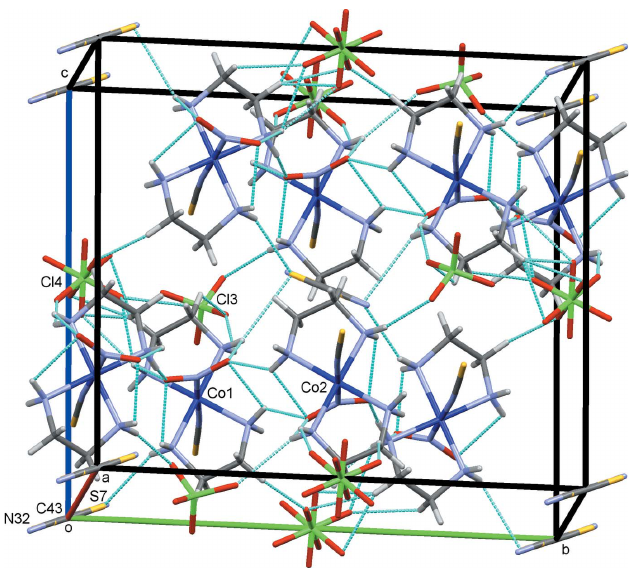
Figure 6 The crystal structure of (III), projected along a . N—H (cid:2)(cid:2)(cid:2) O/N and C— H (cid:2)(cid:2)(cid:2) O hydrogen bonds are shown as blue dashed lines. Both possible orientations of the disordered thiocyanate (S7/C43/N32) and perchlorate (Cl4/O16–O19) ions are indicated.